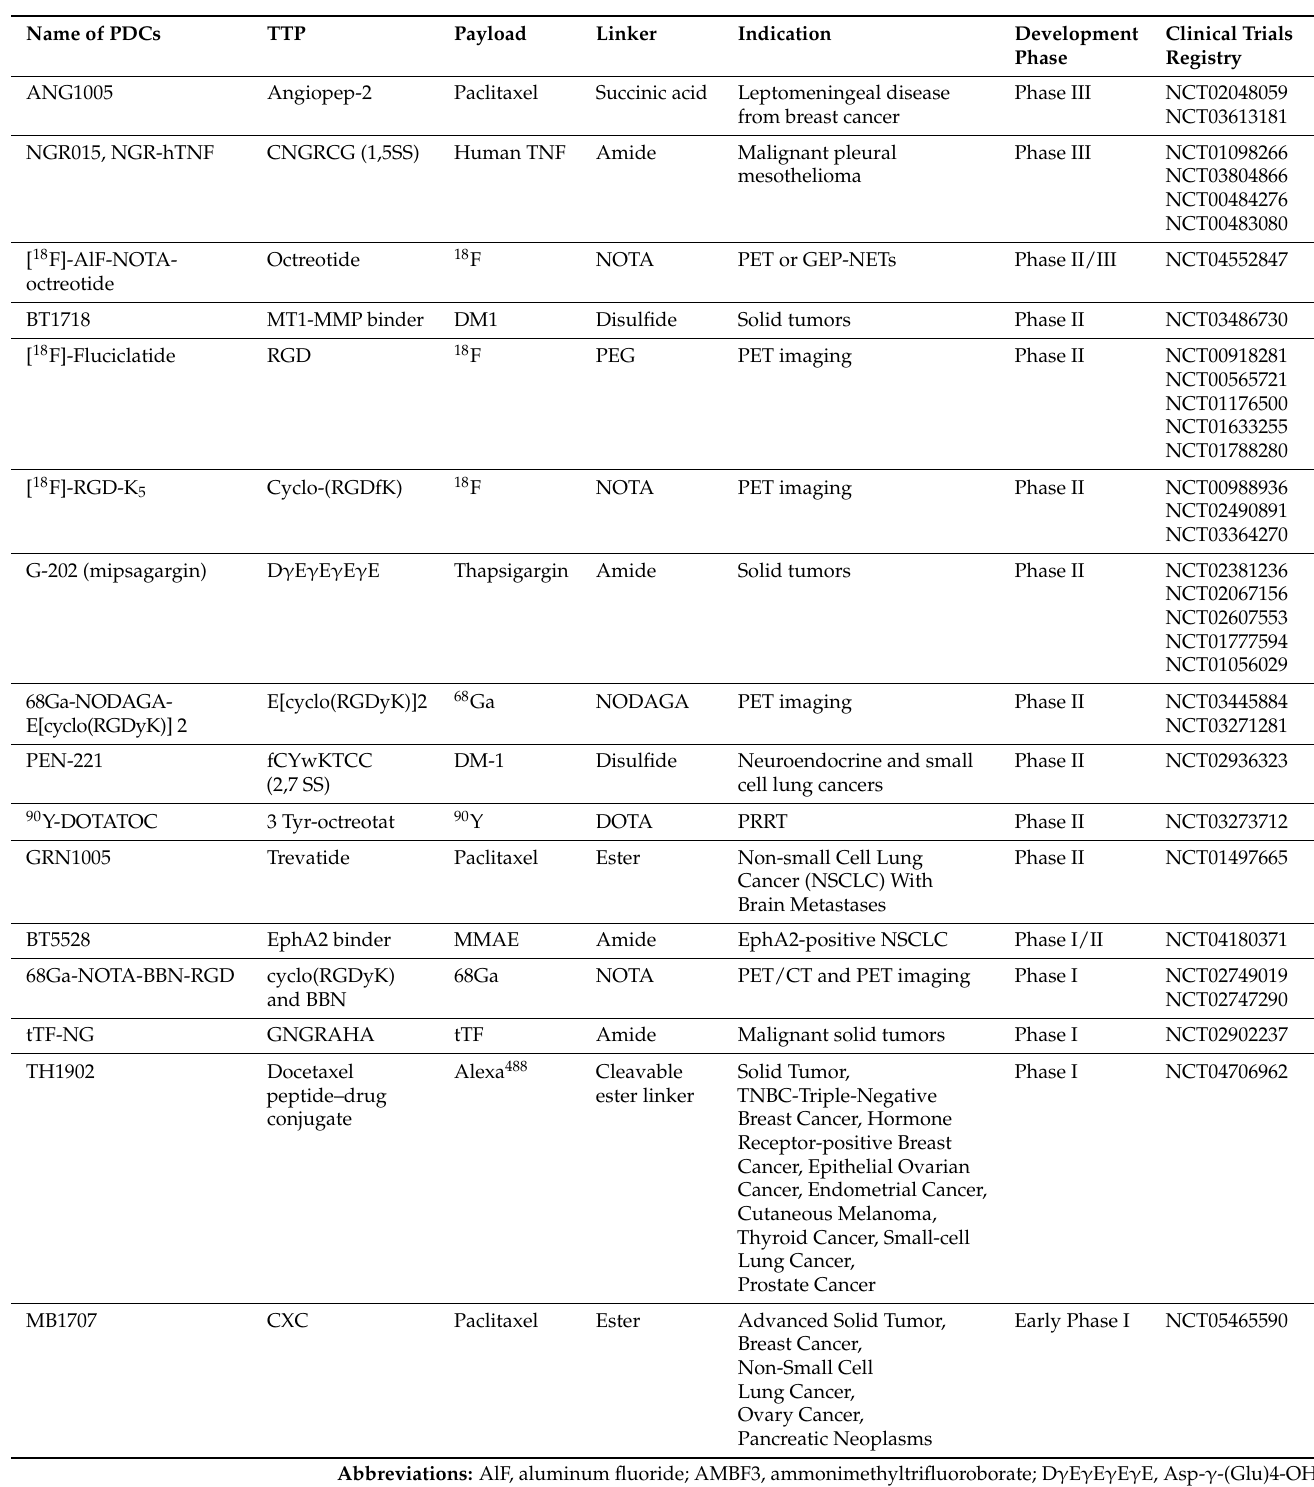
Table 5. Various PDCs under different stages of clinical